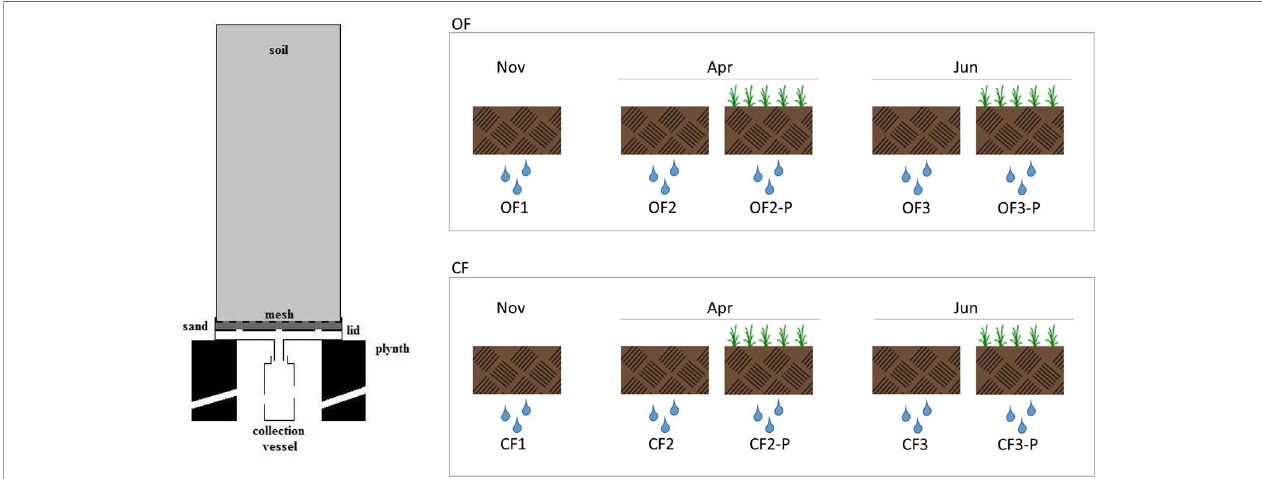
FIGURE 1 | Cross-section of the soil column and leachate collection apparatus and experimental setup used in this study. The leachates were collected from organic farming soils (OF1, OF2, and OF3) or from conventional farming soils (CF1, CF2, and CF3). OF1 and CF1 were sampled in November; OF2, OF-P2, CF2, and CF-P2 were sampled in April; OF3, OF-P3, CF3, and CF-P3 were sampled in June. OF1, OF2, OF3 and CF1, CF2, CF3 refer to leachates collected from bare soil columns. OF-P2, OF-P3 and CF-P2, CF-3 refer to leachates collected from planted soil